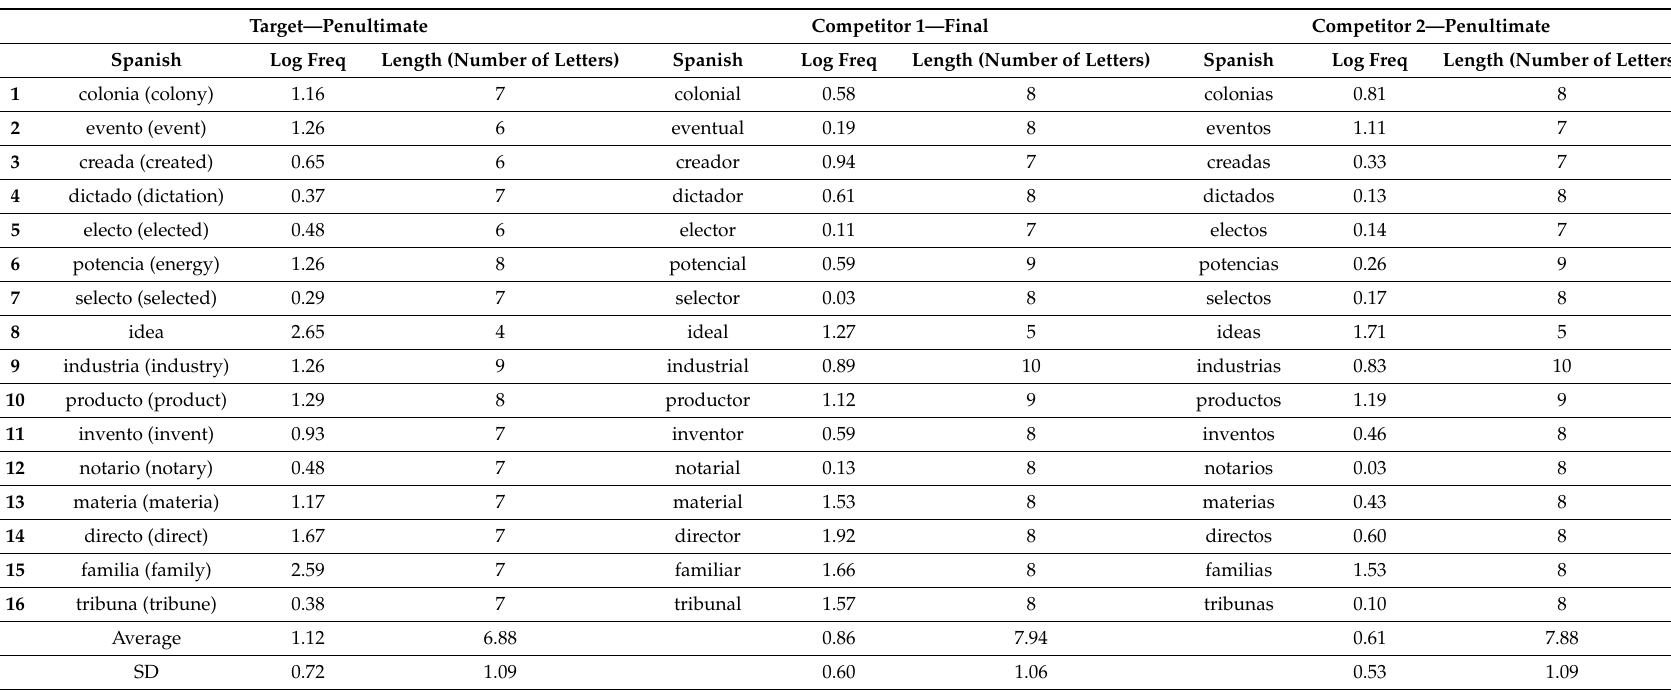
Table A5. Information regarding the experimental trials in this experiment. Cognate condition. The log frequency of the target and competitor words was obtained using the subtitle token corpus in EsPal (Duchon et al. 2013), provided by the Basque Center on Cognition, Brain, and